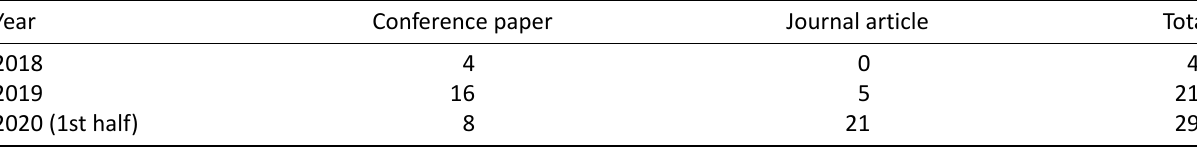
Table 1. Evolution of the studies on deepfake indexed in WoS and